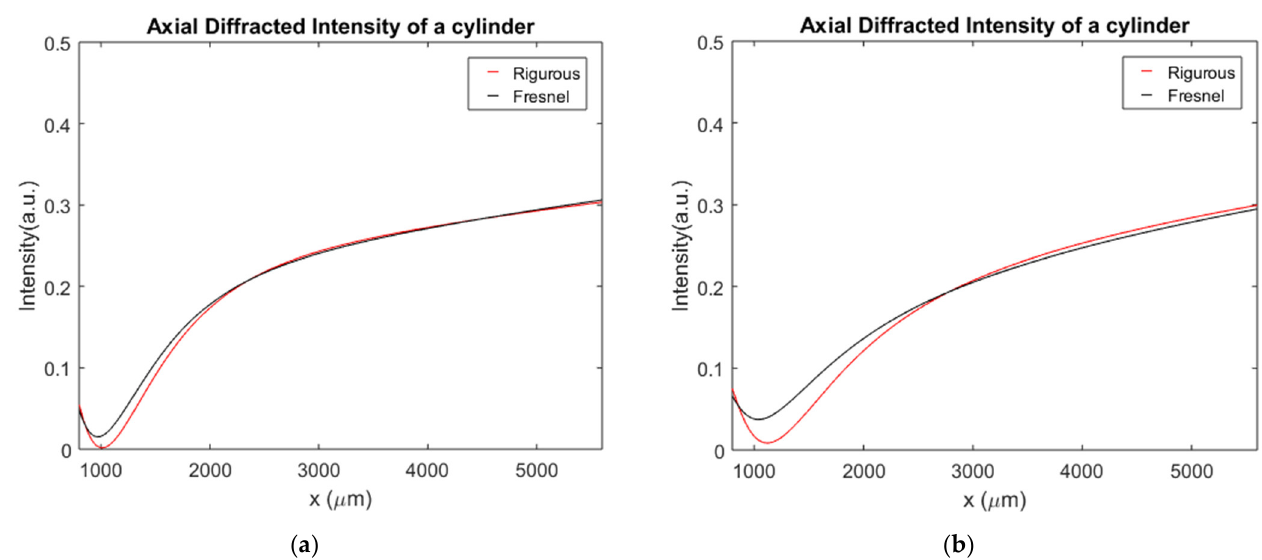
Figure 5. Intensity of the diffraction pattern as a function of the axial distance for a dielectric cylinder with internal radius a = 30 µm: ( a ) with refractive index n = 1.85; ( b ) with refractive index n = 3.4.